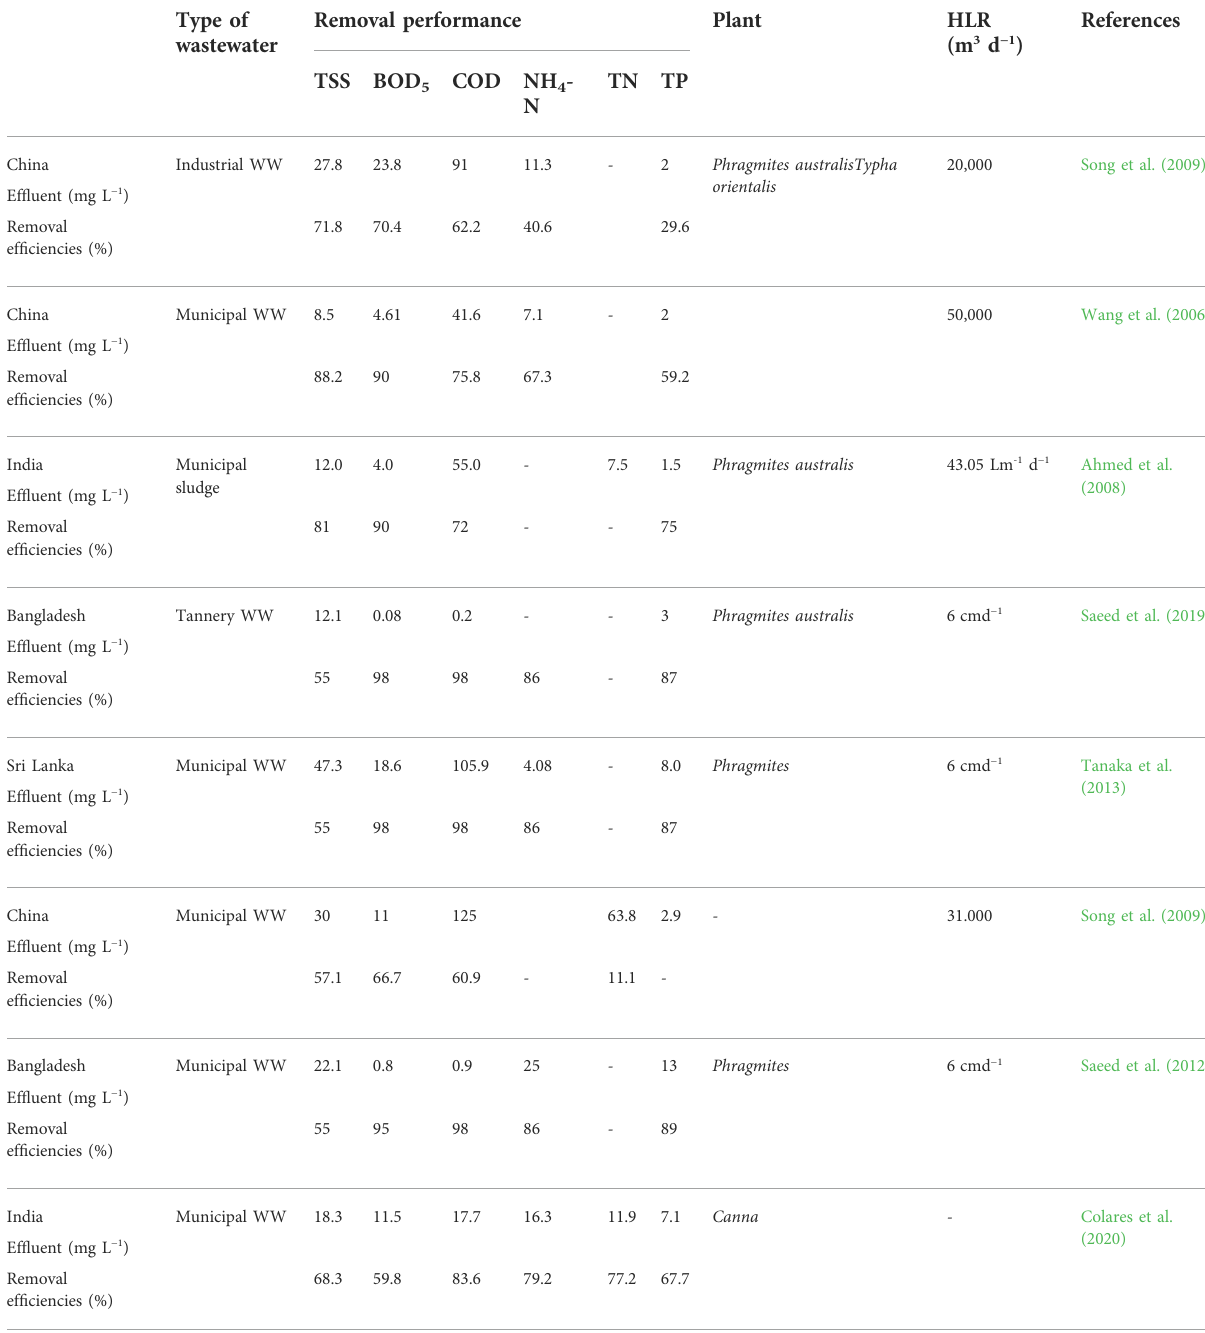
TABLE 2 An overview of the HSSF systems ’ operating characteristics and treatment performance in Asian